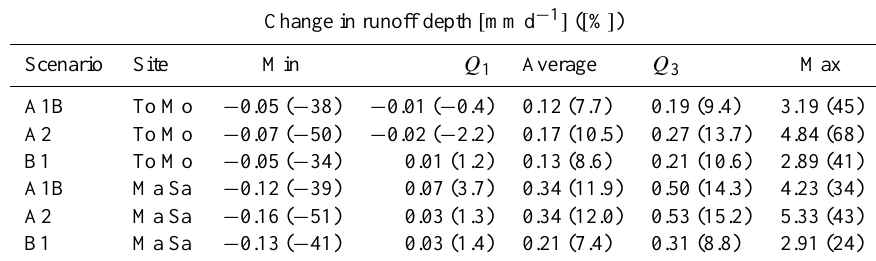
Table 6. Absolute (relative) change in annual runoff quantiles for the To Mo and Ma Sa catchments, all scenarios. Change in runoff depth [ mmd − 1 ] ( [ % ]